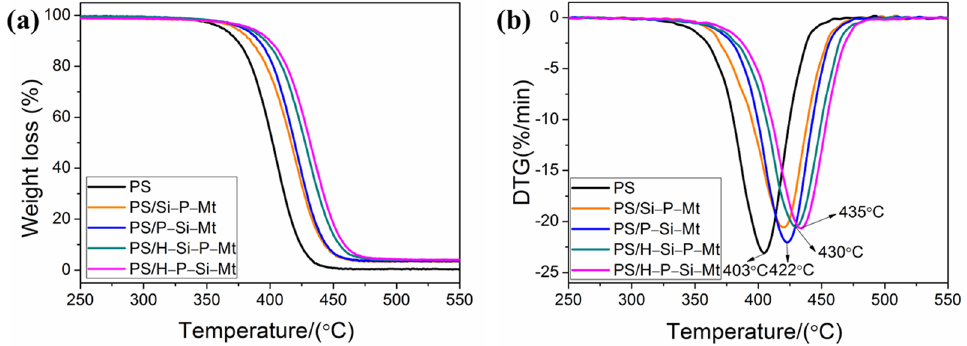
Figure 7. ( a ) TGA and ( b ) DTG curves of pure PS and PS/OMt nanocomposites. Table 4. TGA and DTG data of pure PS and PS/OMt nanocomposites.